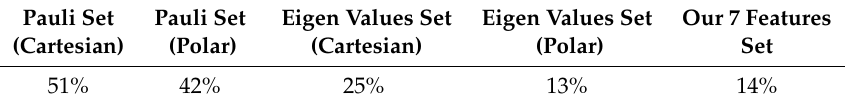
Table 4. Normalized RMSE (m) for canopy cover estimation with different feature sets.